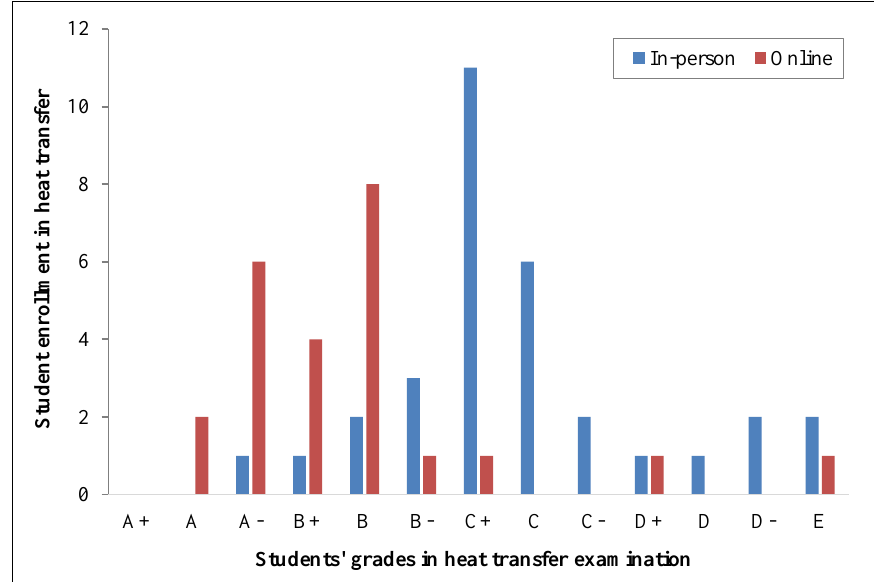
Figure 6. Grade distribution in Heat Transfer course in virtual and in-person learning